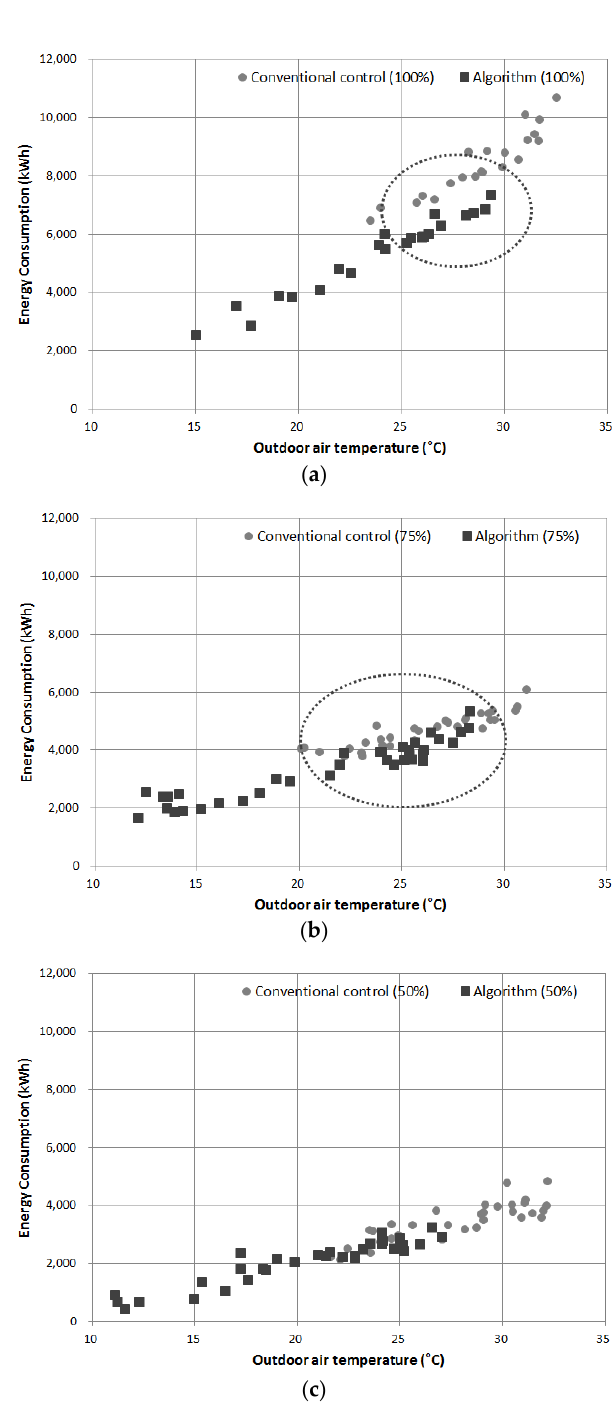
Figure 10. Comparison of changes in energy consumption according to outdoor air temperature ( a ) 100% load; ( b ) 75% load; and ( c ) 50% load.